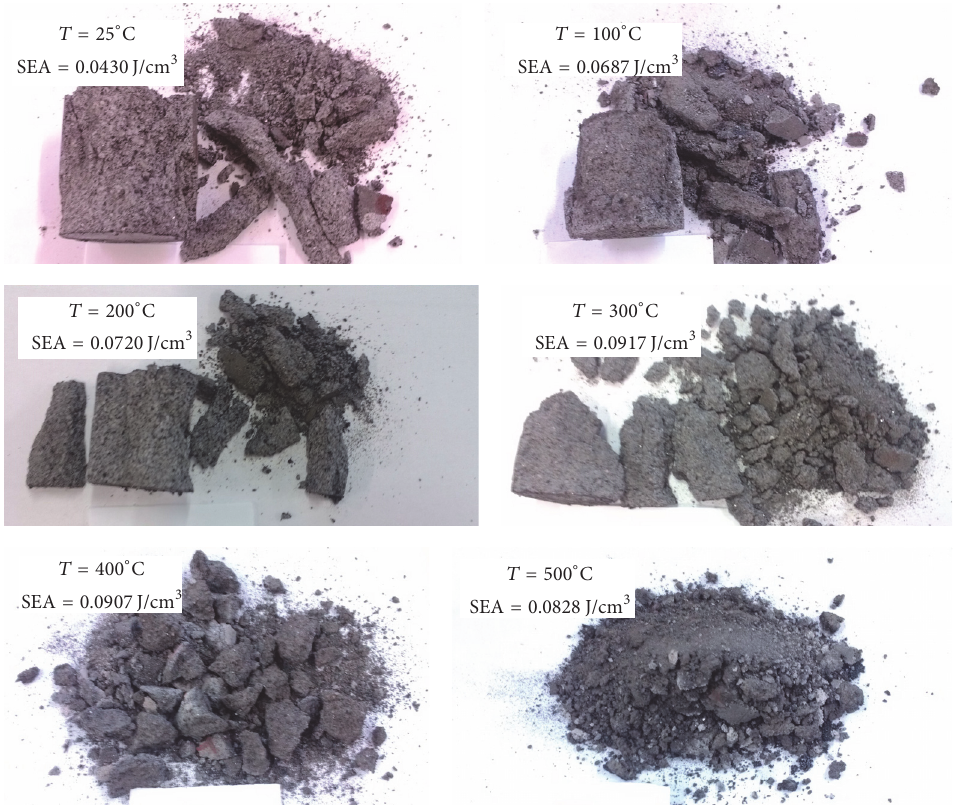
Figure 9: Failure patterns of coal rock under different temperatures.